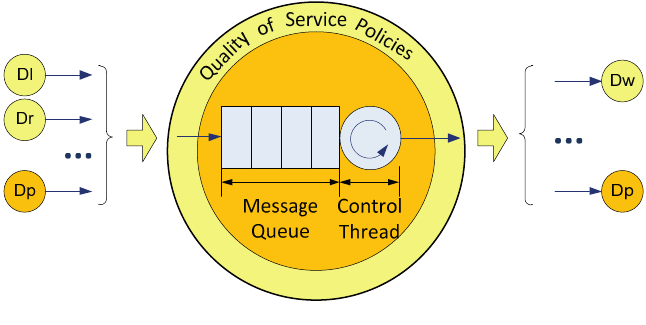
Figure 3. Components of a Data